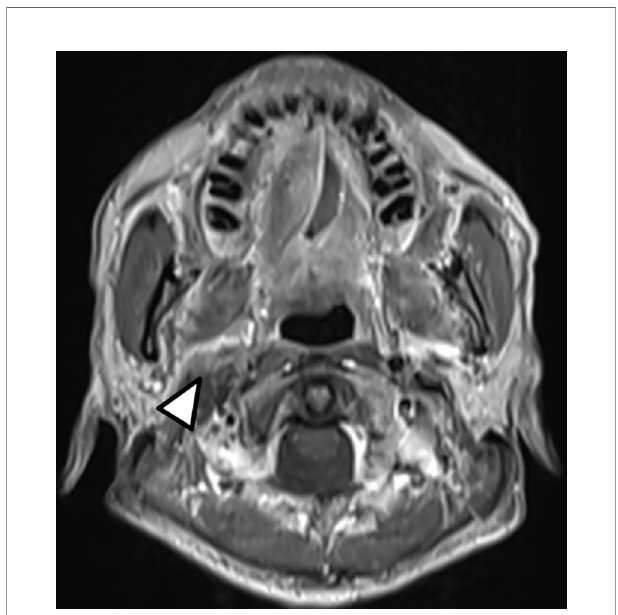
FIGURE 4 | Post-treatment T1-weighted head and neck MRI showed decreased size of the right carotid body tumor with slightly anterior displacement of the right parapharyngeal fat (Arrow head).